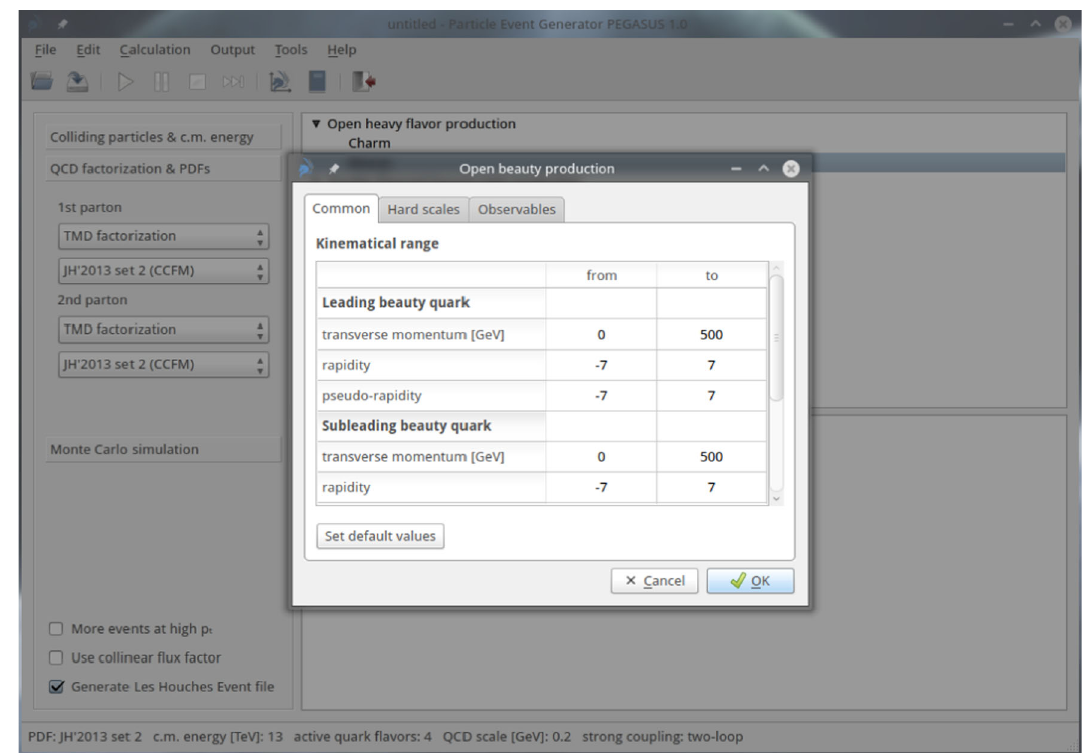
Fig. 2 One can optionally correct the default kinematical restrictions, list of requested observables and corresponding binnings for any processes (part